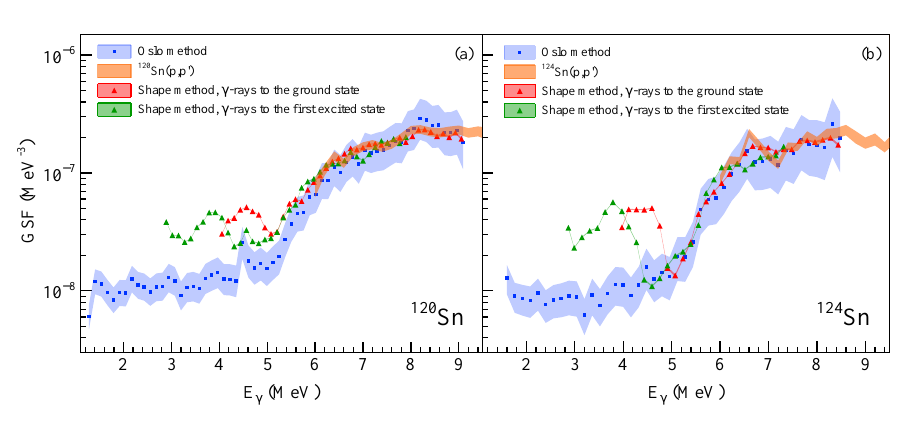
Figure 1. GSFs of 120 Sn and 124 Sn obtained with the Oslo method (blue band), the Shape method for γ -decays to the ground state (red band) and to the first excited state (green band) and the inelastic proton scattering experiment (orange band)